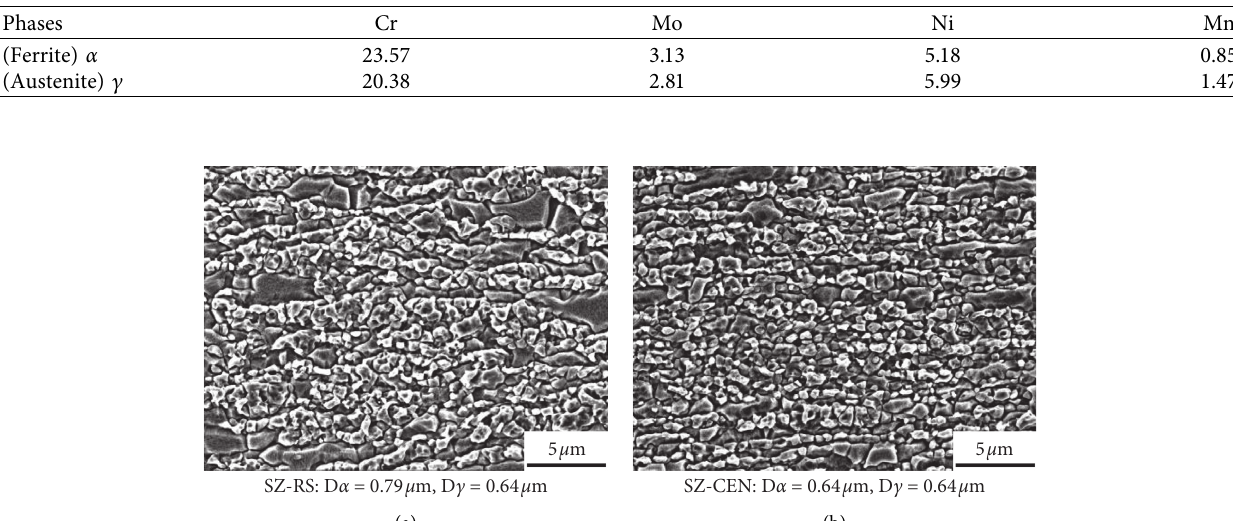
Figure 10: Grain sizes of α and c in TMAZ and SZ of the joints welded at different rotation speeds. Table 3: Chemical compositions of the recrystallized ferrite and austenite in SZ (wt%).